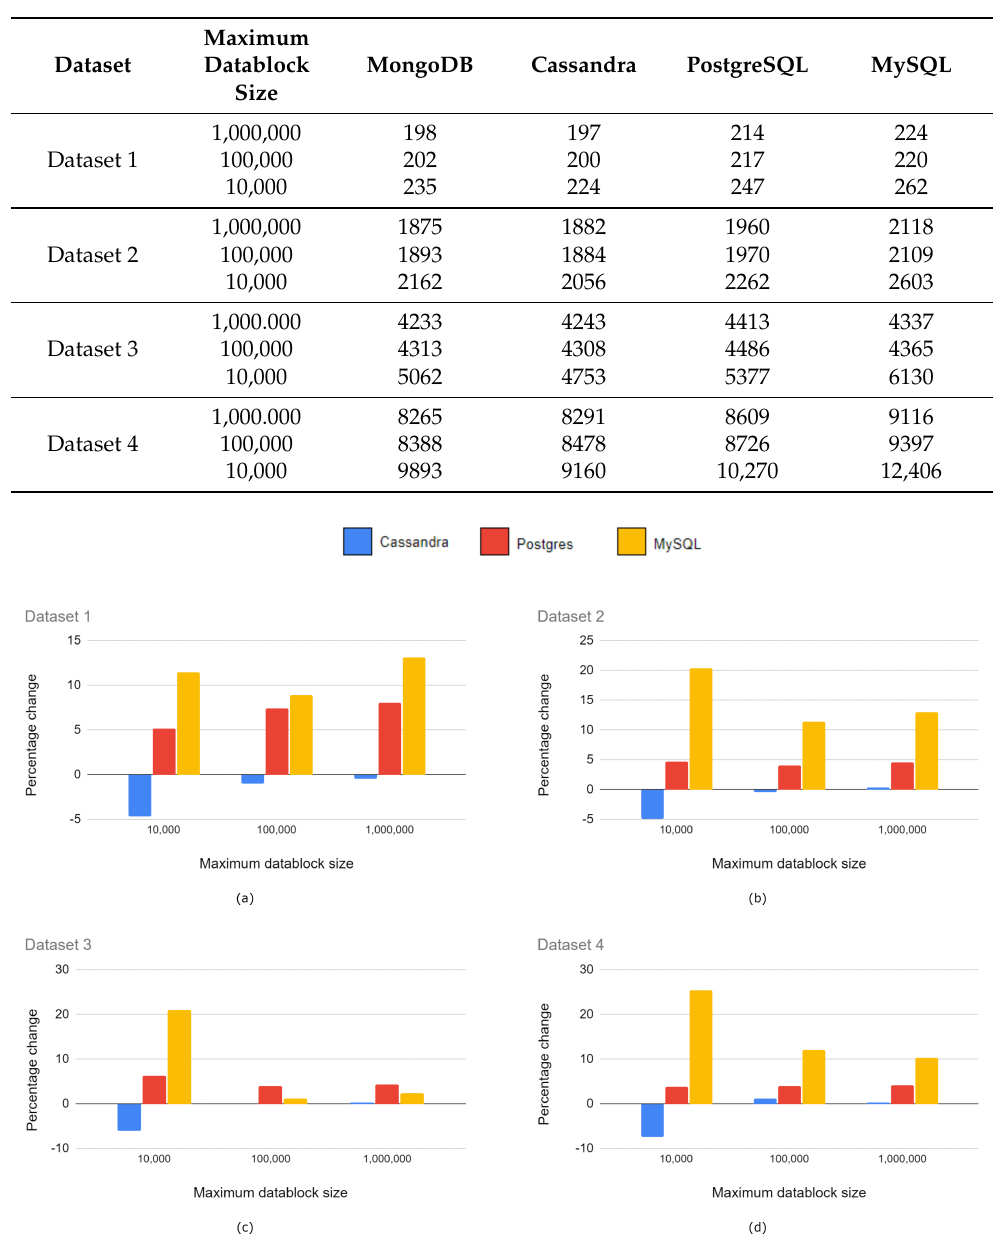
Table 3. Storage required (in MB) by the implementations based on MongoDB, Cassandra PostgreSQL and MySQL.